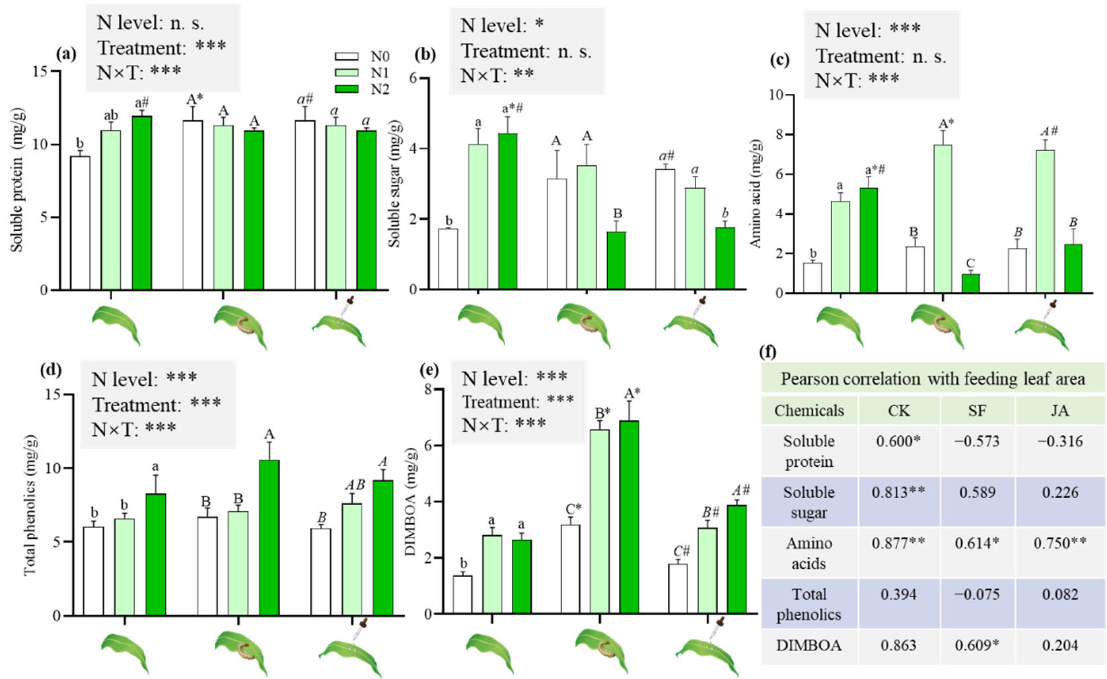
Figure 3. Effects of N supply on the nutrient and secondary metabolites of maize under different induced treatments. GLM results of testing for N level and induced treatment effects are shown (n.s., not significant; * p < 0.05; ** p < 0.01; *** p < 0.001); different lowercase, uppercase and italic lowercase letters above the bars indicate significant differences among different N levels under the same induced treatments. The asterisk “*” above the bars indicates significant differences between maize with and without S. frugiperda attack; “#” above the bars indicates significant differences between maize with and without JA application. Pearson correlation analysis results are shown (* p < 0.05; ** p < 0.01).